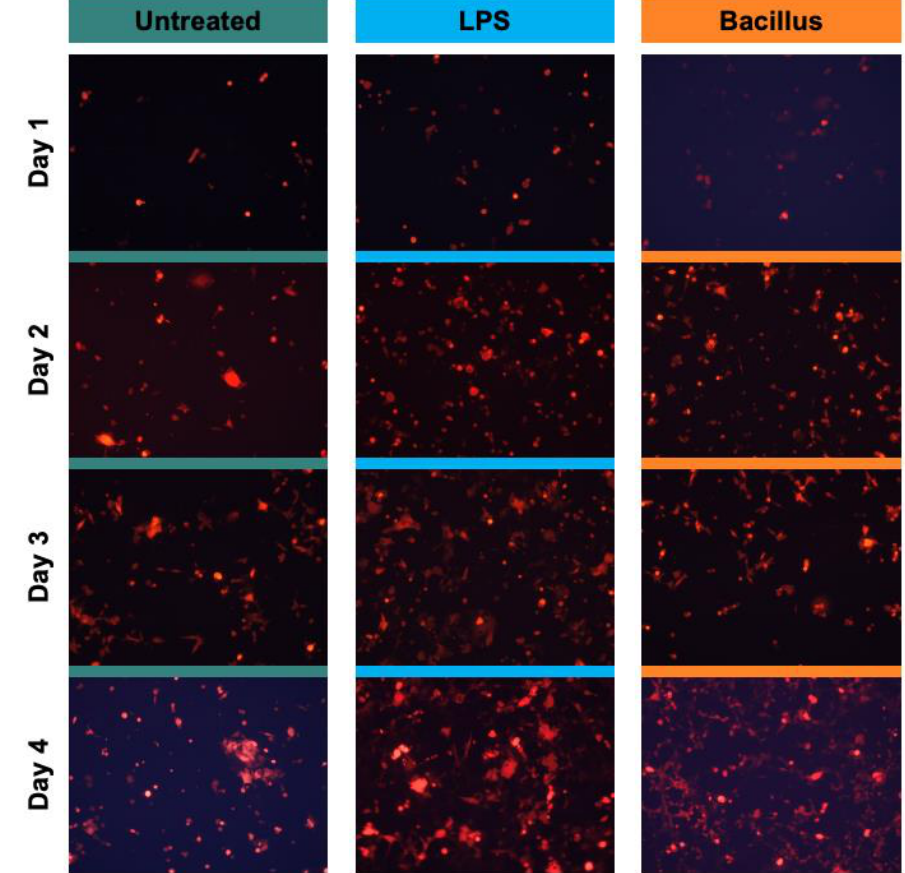
Figure 2. The bacterial stimulus promotes the growth of colorectal cancer cells over time. In the outer inlets of the device, approximately 1000 bacterial cells were loaded. About 40,000 HCT 116 cells labeled with a red fluorescent protein (RFP) were injected into the middle inlet. Cells were cultured for 24 hrs with Bacillus or lipopolysaccharide (LPS; 10 ng/mL). Then microchannels were washed thoroughly to remove non-adherent HCT 116 cells and extra bacterial cells. Media was fed at a 5 µL/min flow rate. These experiments were performed without hypoxic conditions. A representative image for each time point is shown.